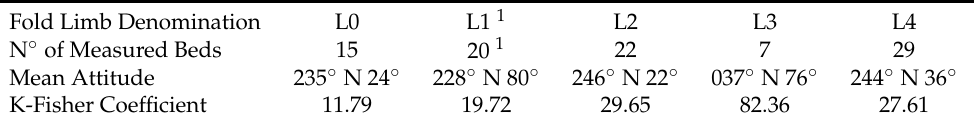
Table 7. Fold limb mean attitude (dip direction and dip) and K-Fisher dispersion coefficient.